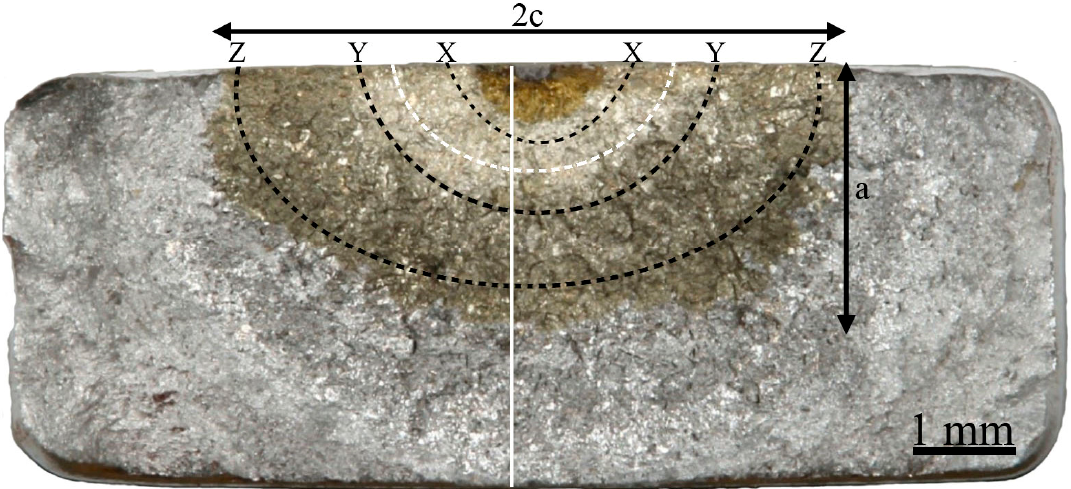
Figure 6. Overview of H-A fracture surface. The two tint temperatures, 450 and 350 °C, resulted in the two different golden color contrasts shown in the figure. “2c” represents the width and “a” the length of the crack. The three semi-elliptical dashed lines X, Y, and Z show profiles where fractography was performed in higher detail. The white dotted line in-between the X and Y lines corresponds to the Δ K 23 (cid:1839)(cid:1842)(cid:1853)√(cid:1865) . The vertical white line indicates the cross-section where crack profiles were investigated.